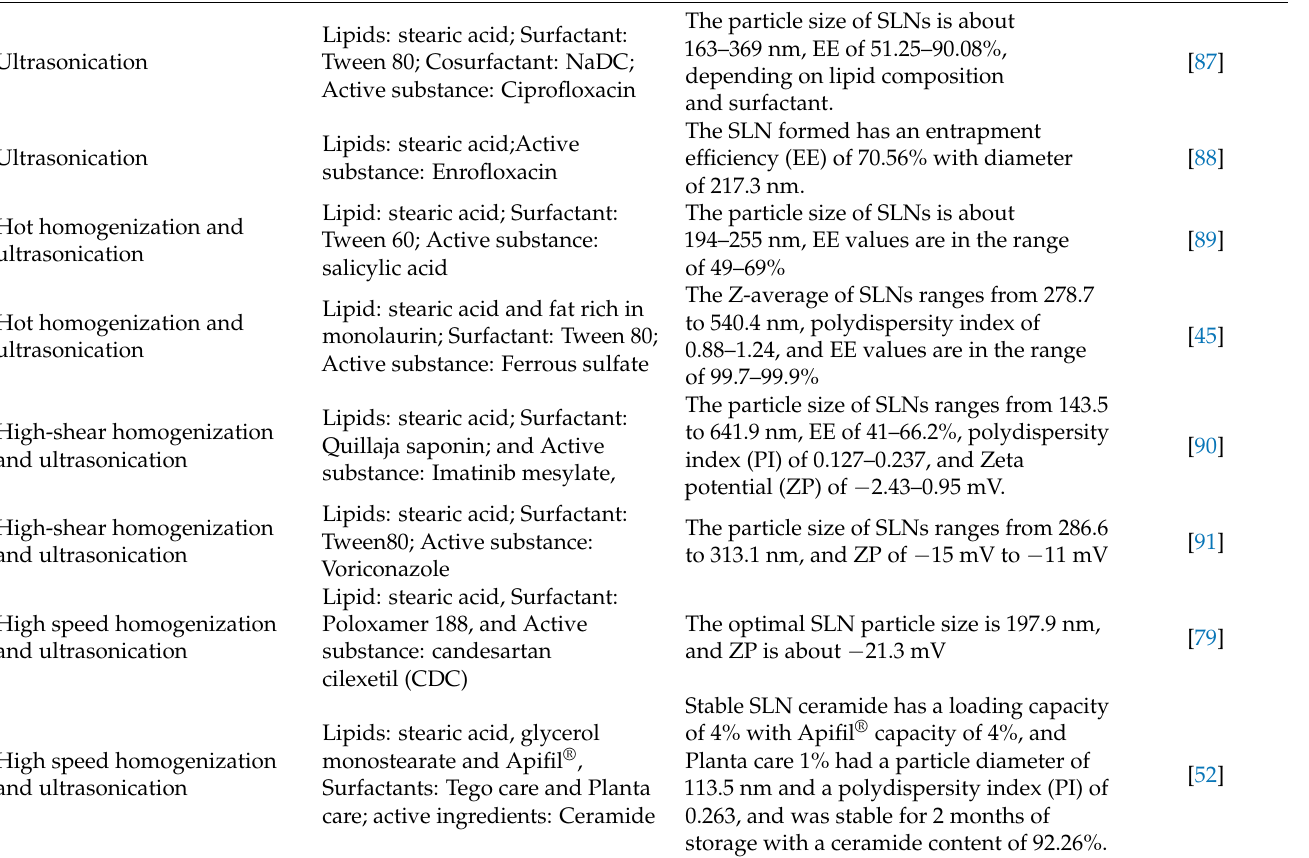
Table 2. Various uses of ultrasonication and high-shear homogenization methods in the fabrication of SLNs of various active